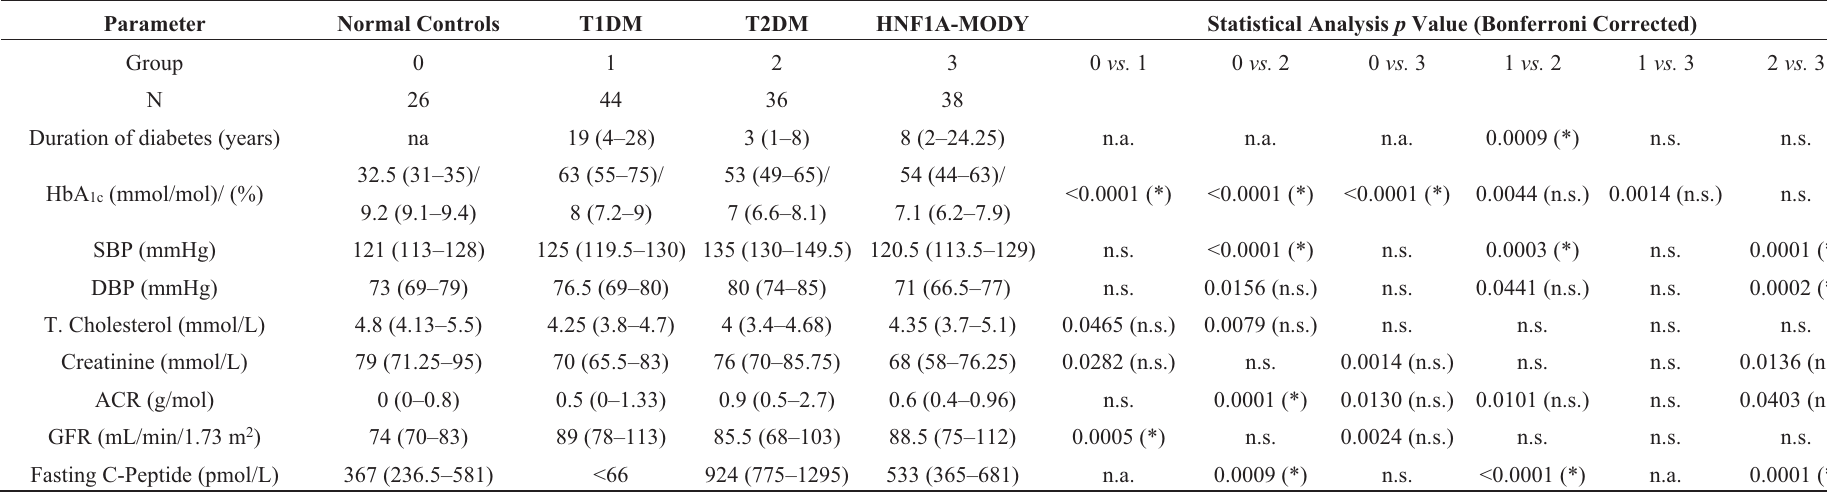
Table 1. Clinical characteristics of patient groups. n.a. = not applicable, n.s. = not statistically significant, (*) = statistically significant with Bonferroni